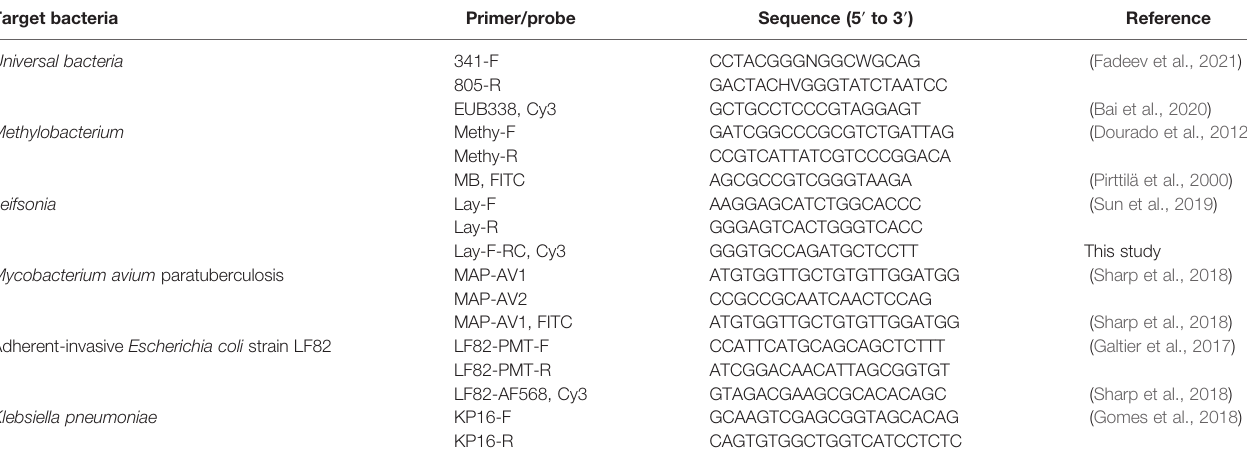
TABLE 1 | qPCR primer pairs and FISH probes for bacteria detection used in this